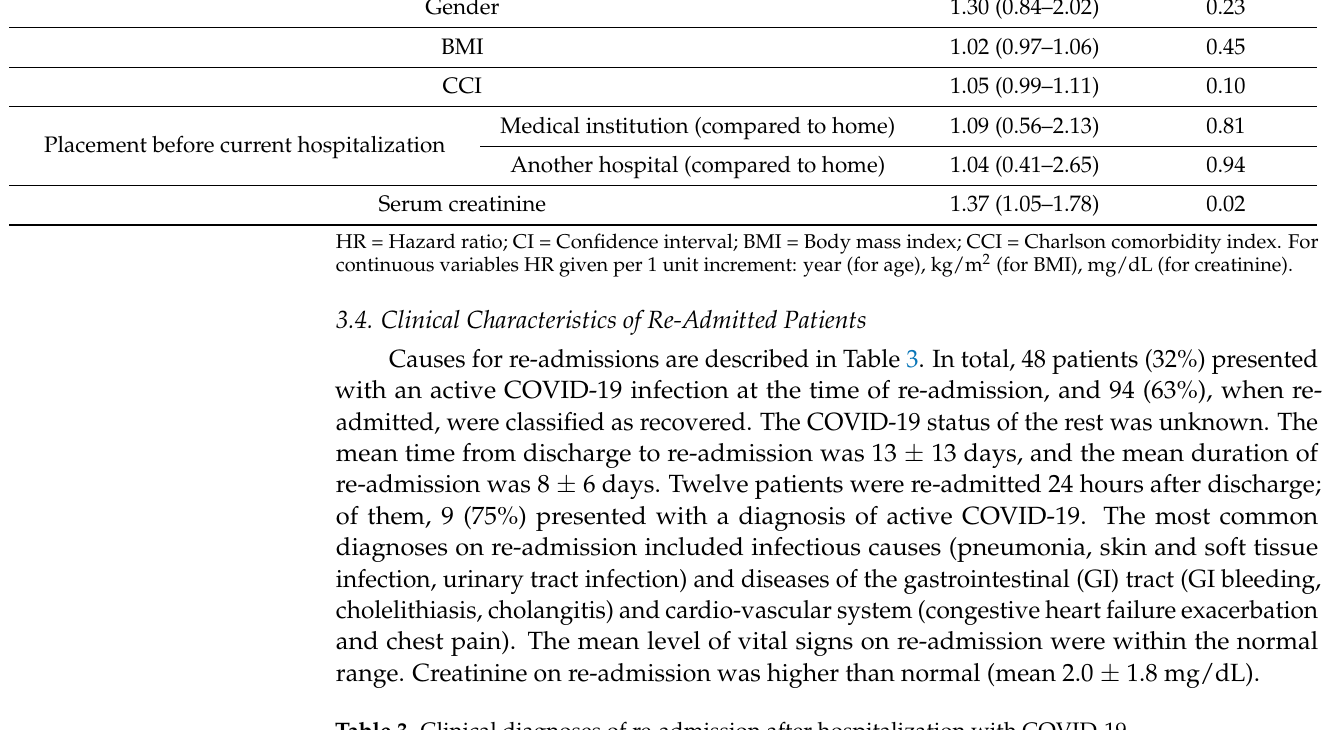
Table 3. Clinical diagnoses of re-admission after hospitalization with